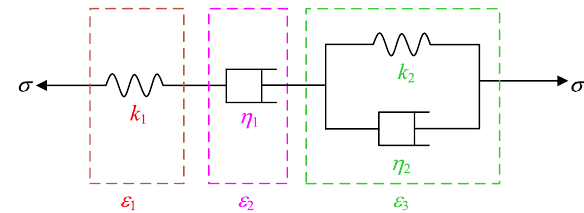
Figure 2. Classic Burgers model.